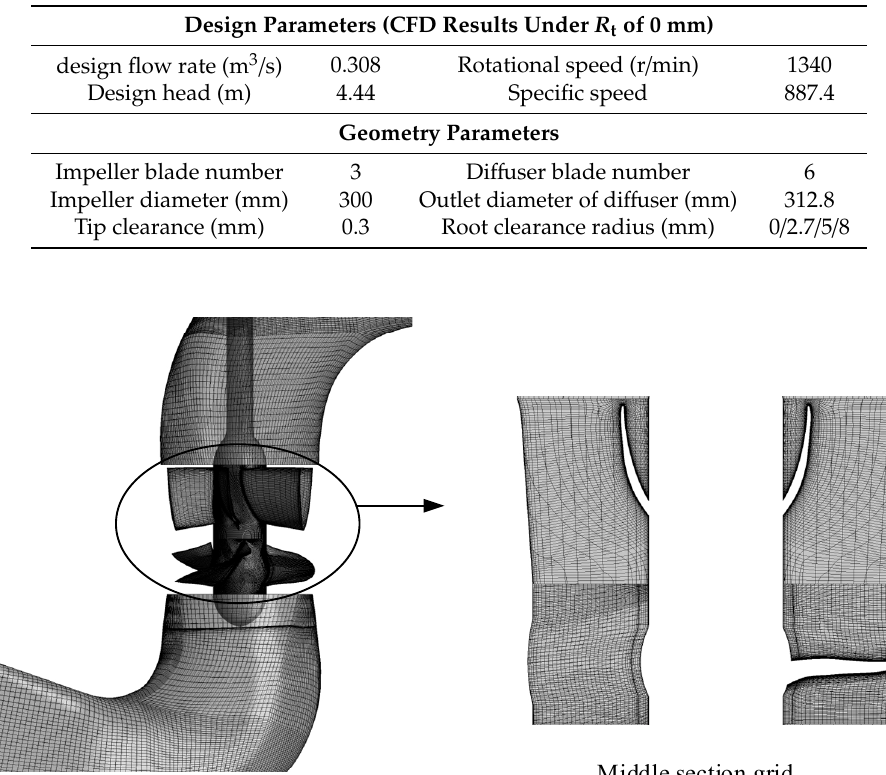
Figure 3. Grid independence of pump device without root clearance. 2.2. Boundary Condition In this study, 25 °C was chosen as the temperature of the working fluid. The governing equation was Reynolds Averaged Navier–Stokes (RANS) equation, which is defined as follows: j j 0 v x ∂ = ∂